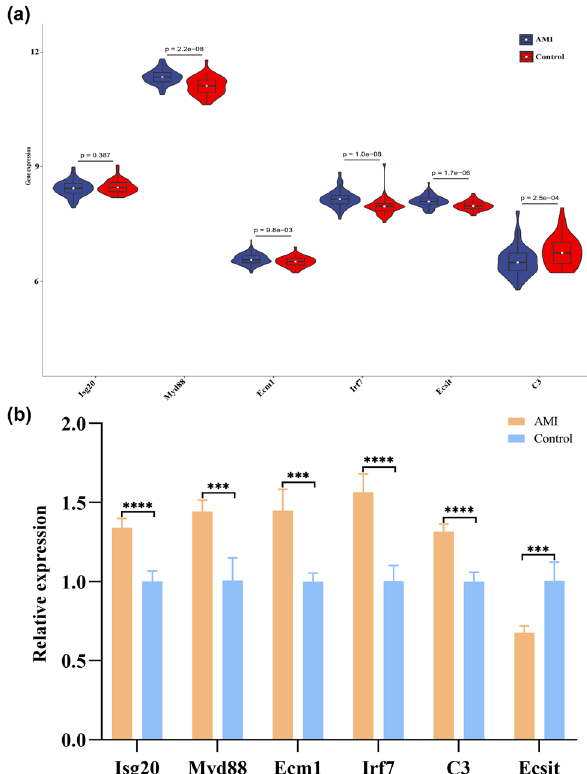
Figure 5: Expression of six highly coexpressed DE mRNAs was ana - lysed. ( a ) The expression of the six coexpressed mRNAs in the GSE59867 dataset. ( b ) qPCR validation of the six coexpressed mRNAs between AMI and normal controls ( ∗∗∗ P < 0.001, ∗∗∗∗ P < 0.0001 )